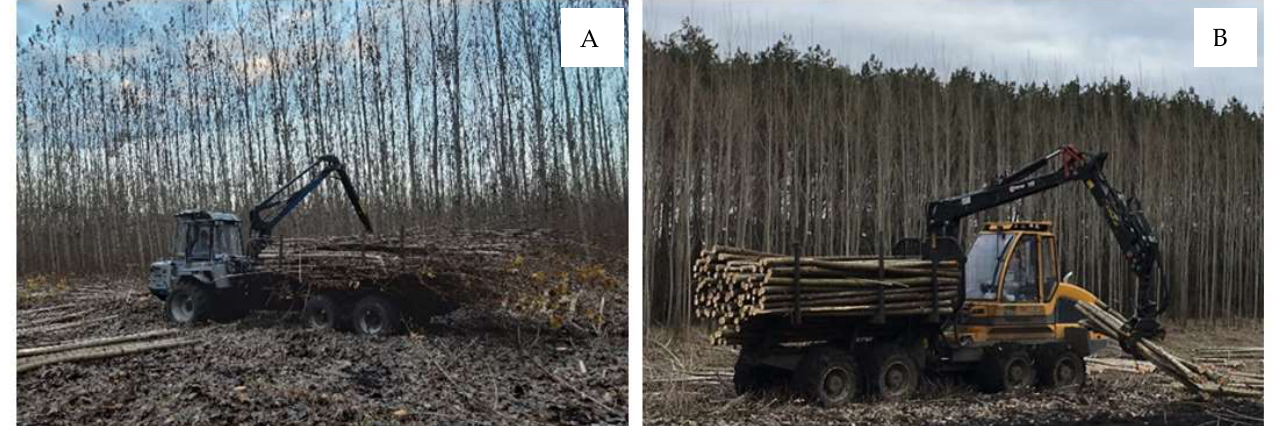
Figure 2. The two forwarders on the test: Vimek 610 ( A ) for the Vimek chain; Sampo FR28 ( B ) for all other chains.